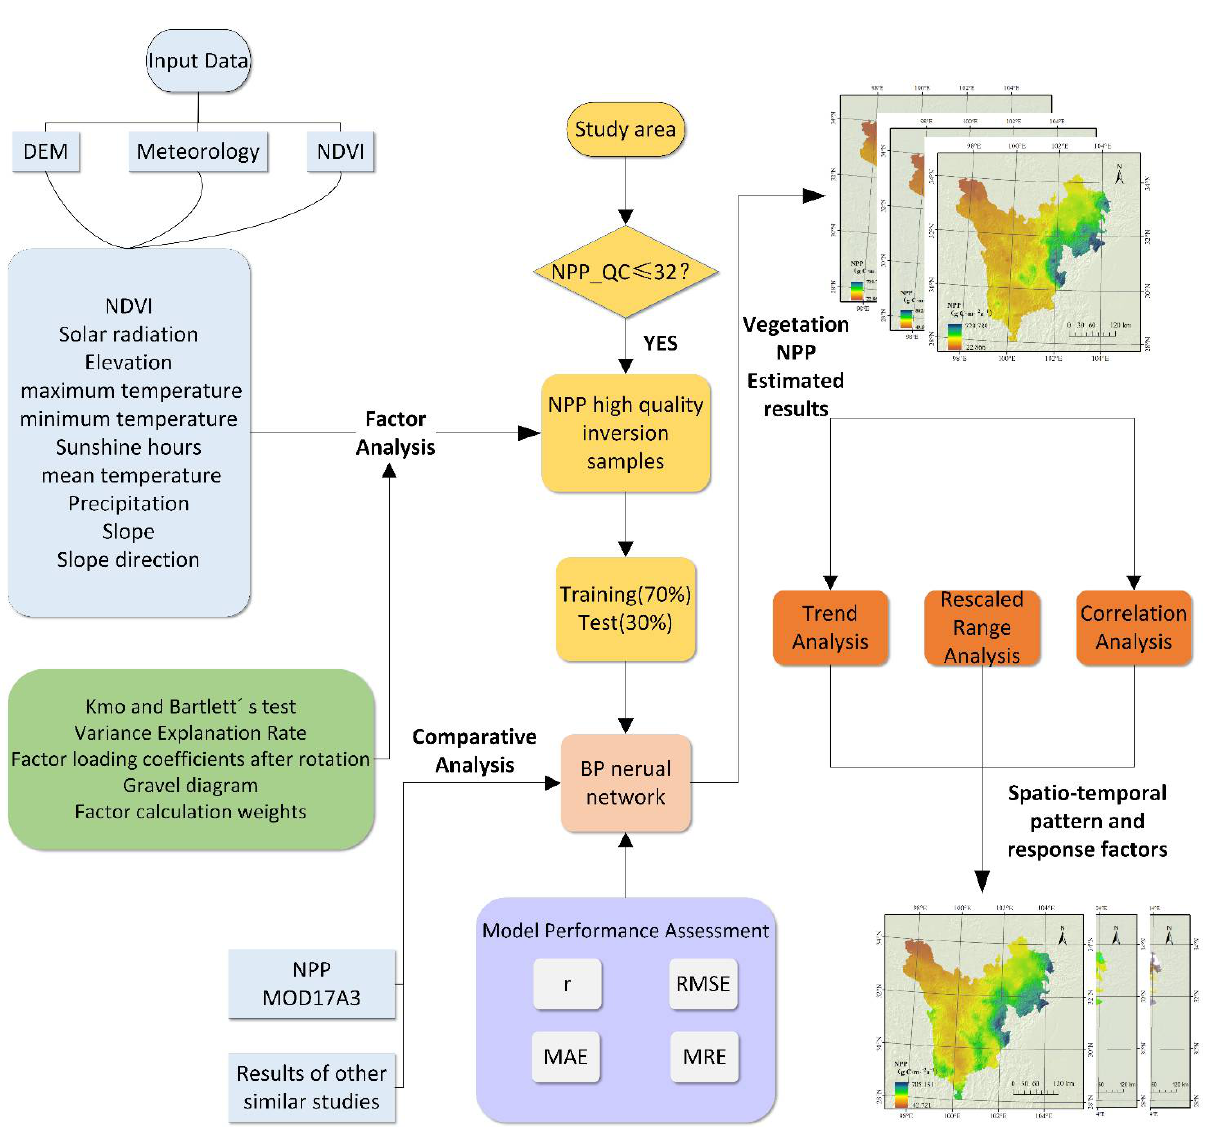
Table 2. Results of the factor analysis adaptation test.